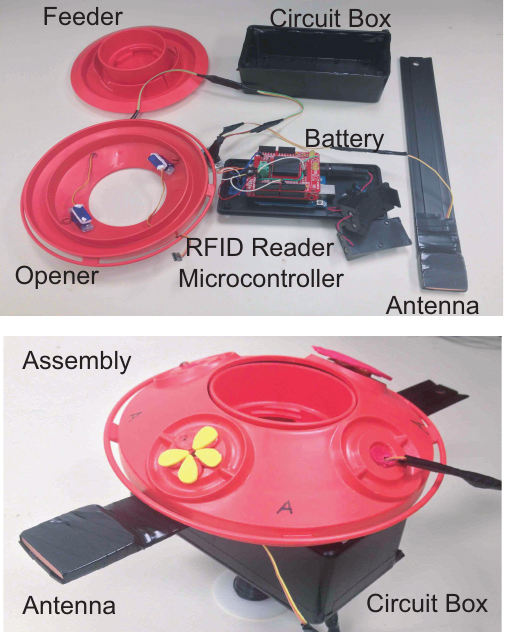
Figure 3. System assembly of the smart feeder. ( Top ) all components with the circuit box; ( Bottom ) final